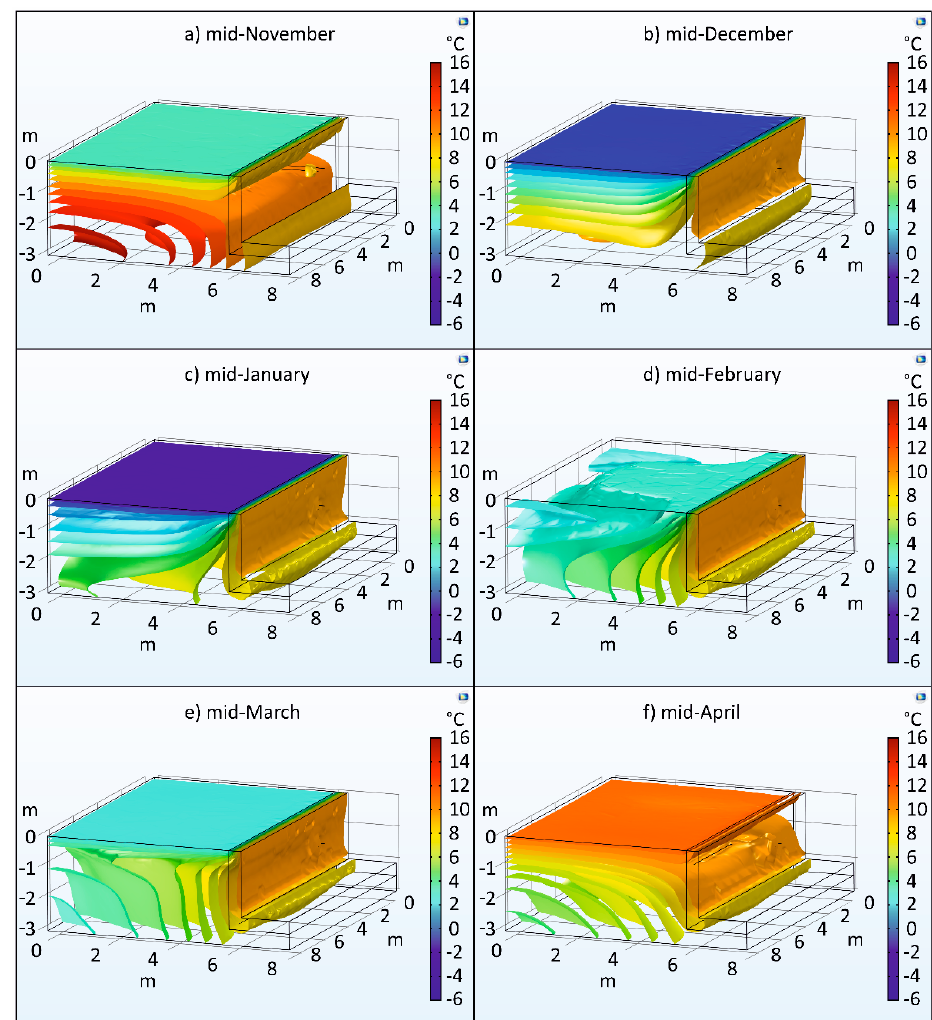
Figure 8. The tri-dimensional temperature isosurfaces for the simulation case 3—HGHE with heat from solar thermal panels: ( a ) mid-November; ( b ) mid-December; ( c ) mid-January; ( d ) mid-February; ( e ) mid-March; ( f ) mid-April.